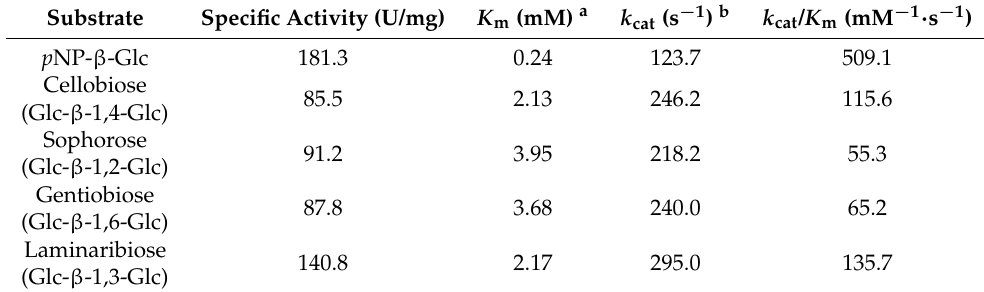
Table 1. Specific activities and kinetic parameters of recombinant TsBgl1 on different substrates.